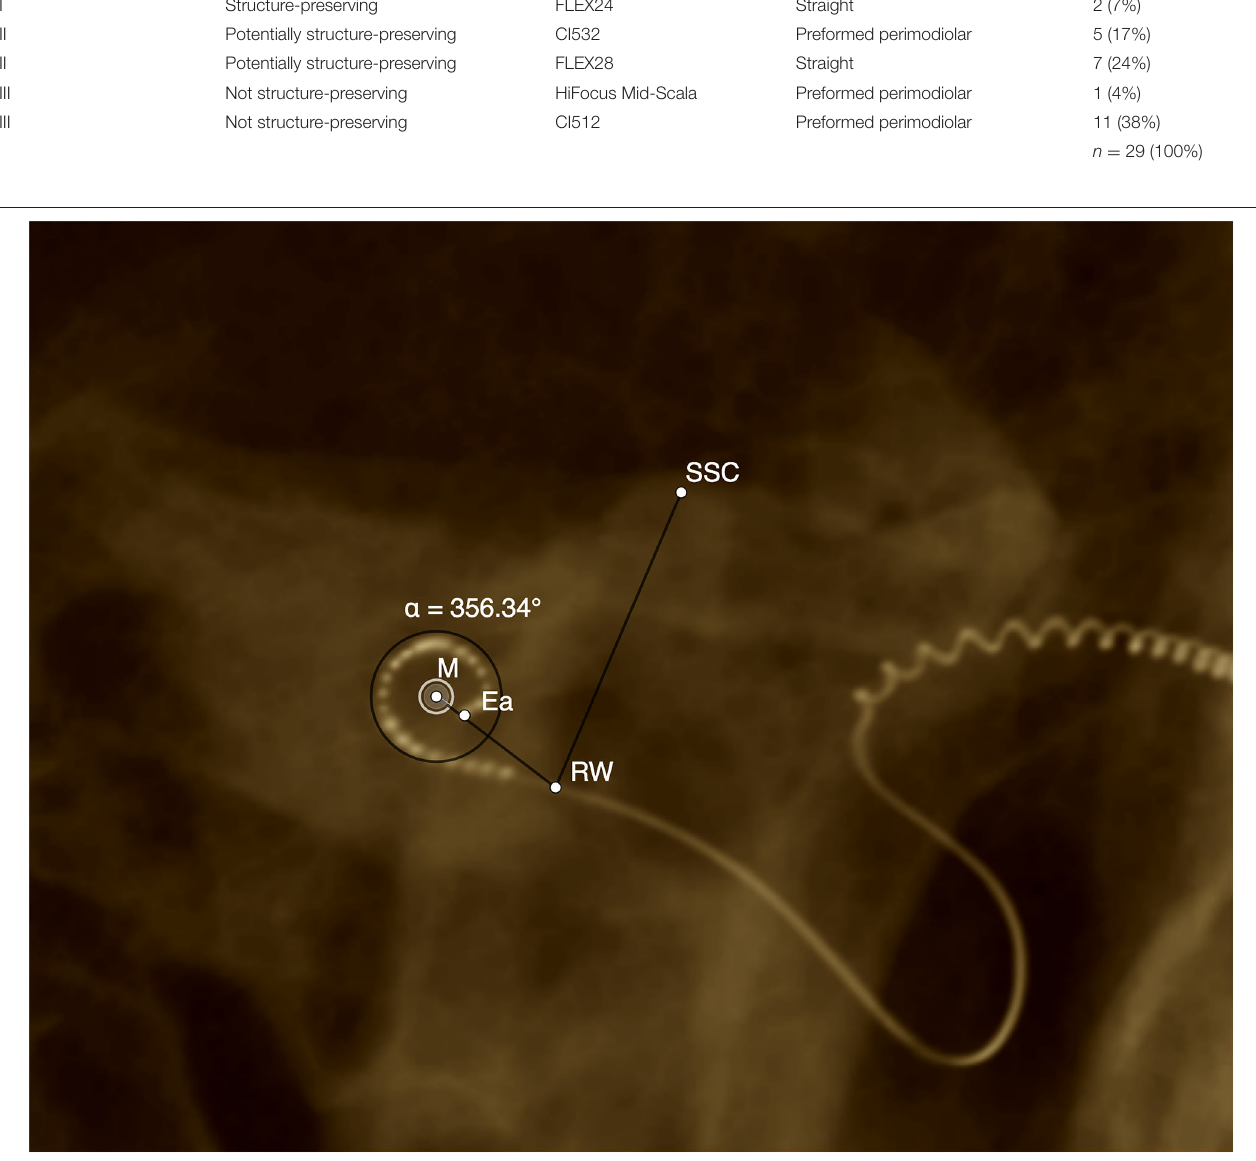
FIGURE 1 | Example DVT reconstruction of CI512 device (left side, patient n20). Determination of insertion angle. M, modiolus; Ea, most apical electrode; RW, round window; SSC, superior semicircular canal; a, insertion angle (356.3 ◦